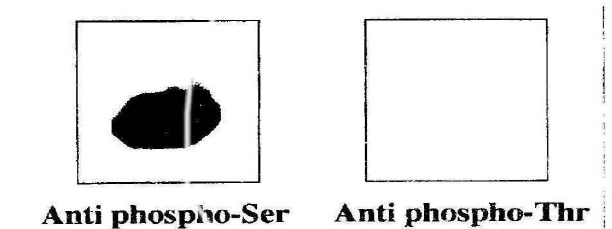
Figure I. Phosphorylation of SPR by CaM KII. Wild type SPR phosphorylated by CaM KII was subjected to SDS-PAGE and <:;\ectroblotted onto a PVDF membrane. Phosphorylated amino acids were immu nostained with anti-phospho Ser/Thr antibody.